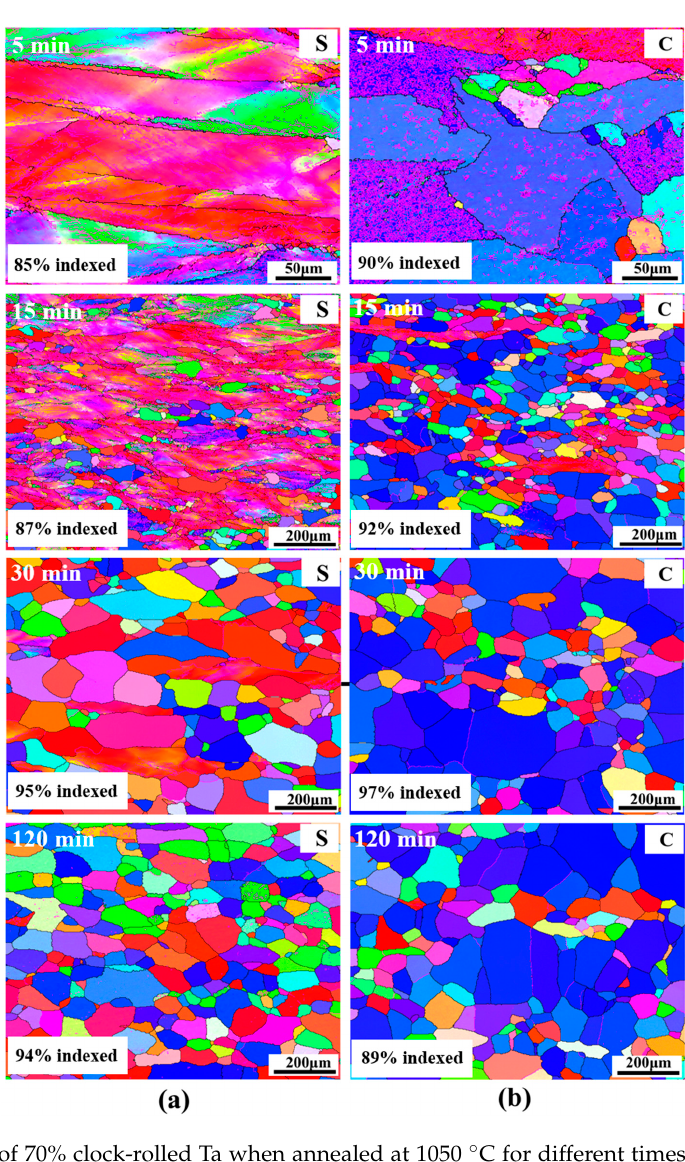
Figure 6. OIM of 70% clock-rolled Ta when annealed at 1050 °C for different times (5 min, 15 min, 30 min and 120 min): ( a ) Surface layer, ( b ) center layer.